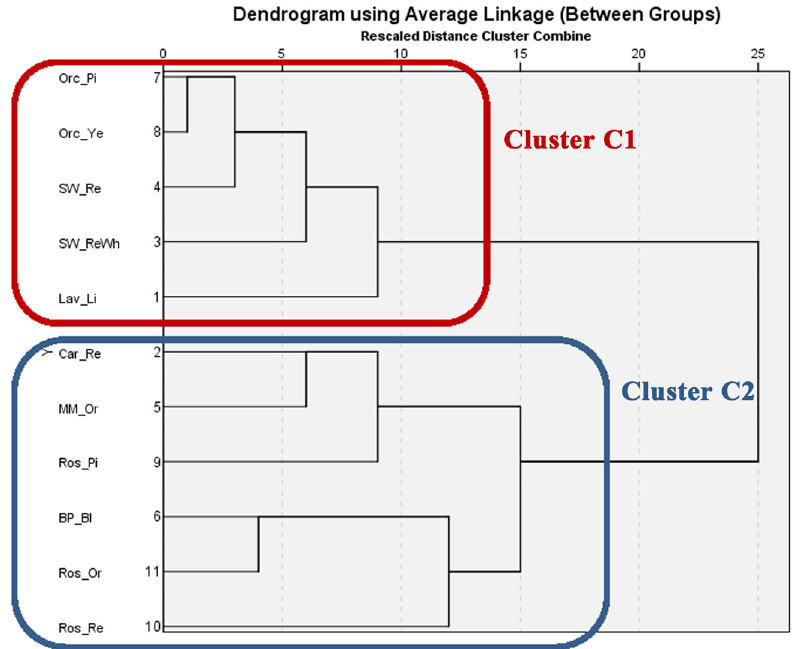
Figure 8: Dendogram obtained through cluster analysis to the fl owers.